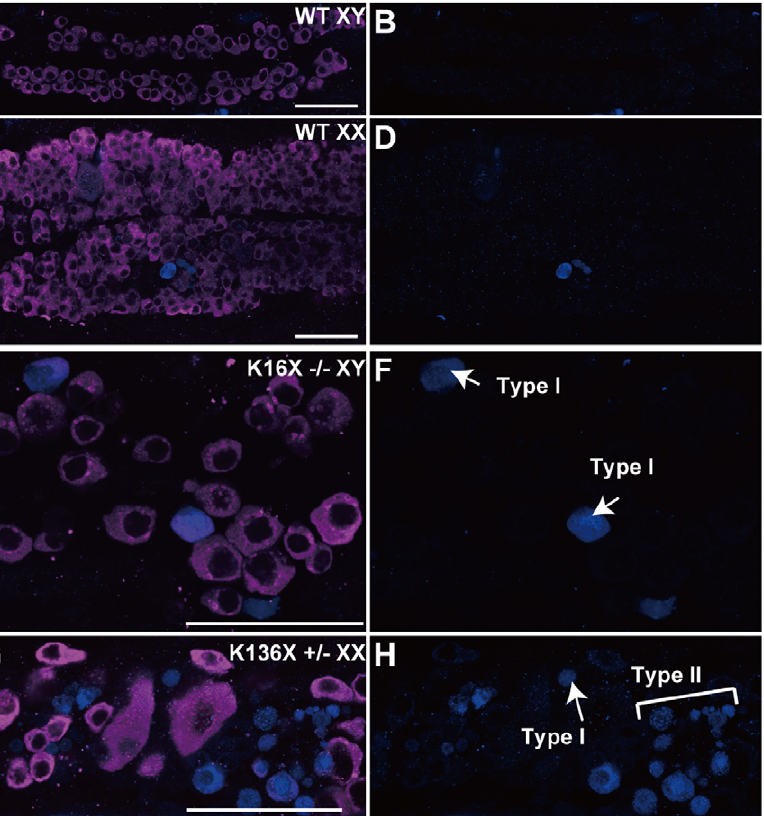
caspase 3 signals (B, D, F and H) are shown. Low levels of germ cell apoptosis only were evident in wild-type XY and XX medaka at 10 dph. However, type I and type II germ cells (type I, arrows; type II, a bracket) were eliminated by apoptosis (Table 2) in the homozygous (E and F) and heterozygous (G and H) mutants. Scale bar, 50 m m.